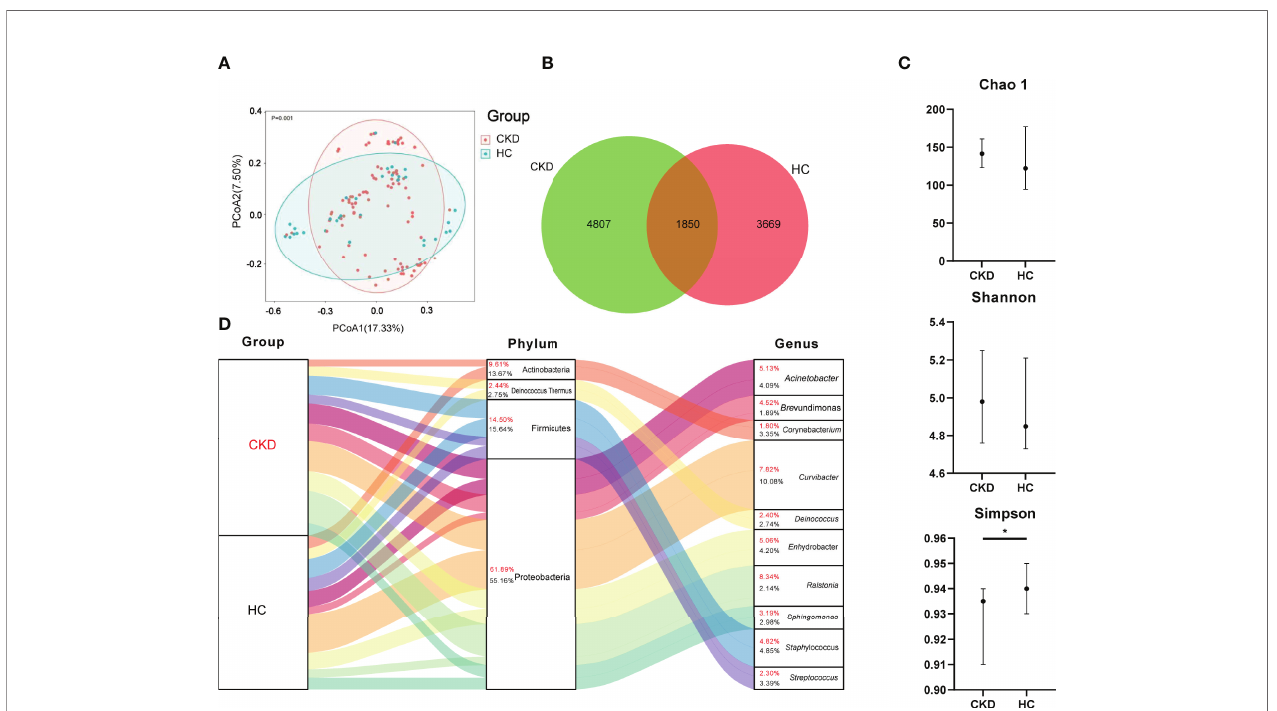
FIGURE 1 | Bacterial community, Venn, diversity, and composition in the groups of CKD and HC. (A) PCoA based on Bray – Curtis distances at ASV level showed different microbial compositions between groups of CKD patients and HC ( p < 0.05). Permutational multivariate analysis of variance (PERMANOVA) was performed for statistical comparisons of samples in the two cohorts. p -value was adjusted by the Benjamini and Hochberg false discovery rate (FDR). (B) Venn diagram showing a dissimilar number of ASVs shared by the groups of CKD and HC. (C) Bacterial richness and diversity measured by Chao1, Shannon, and Simpson were calculated at the microbial ASV level. Wilcoxon rank-sum test was performed and adjusted by Benjamini and Hochberg false discovery rate (FDR). * p < 0.05. (D) Bacterial pro fi le at the phylum and genus level. Sankey plot representing overall gut mycobiome composition and corresponding abundance area for CKD patients and HCs. The taxonomic classi fi cation levels of phylum and genus are displayed. The top 10 most abundant genera and their af fi liated phyla are shown in the Sankey